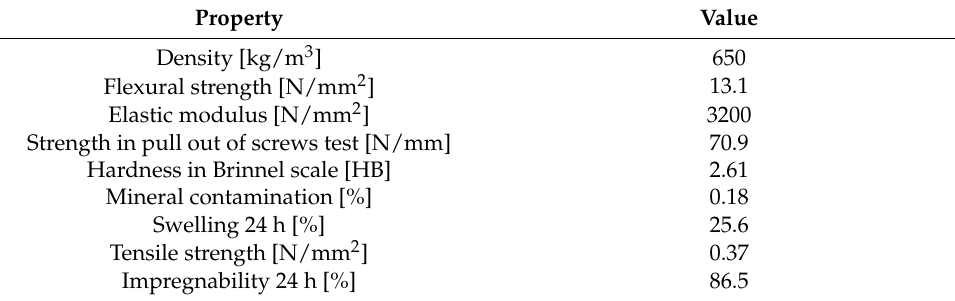
Table 1. Mechanical-physical properties of machined material.